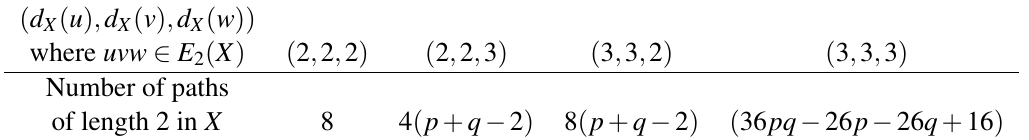
Table 3 Partition of paths of length 2 of the graph X